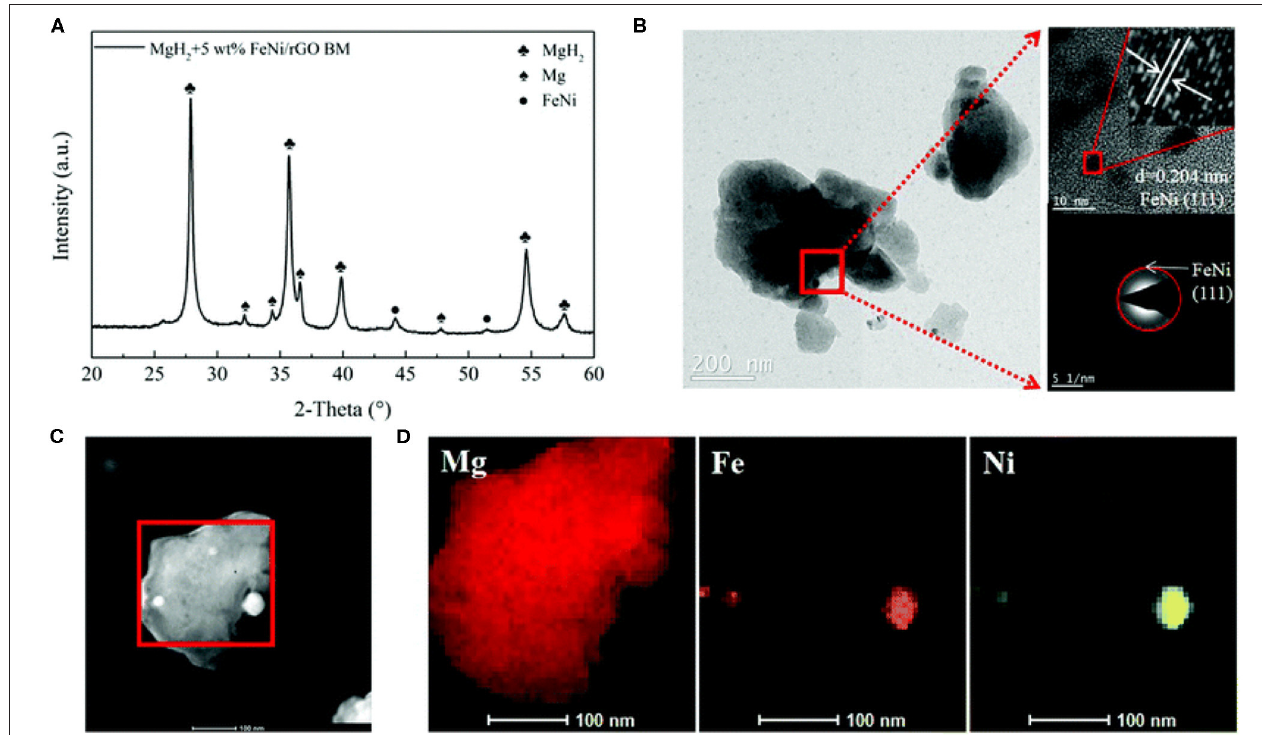
FIGURE 5 | Structural characterization of ball-milled MgH 2 + 5 wt% FeNi/rGO: (A) XRD pattern, (B) TEM photograph with the HRTEM image and SAED pattern, and (C,D) corresponding EDS spectra with elemental mapping of Mg, Fe, and Ni. Reproduced from Ji et al. (2020) with permission from Royal Society of